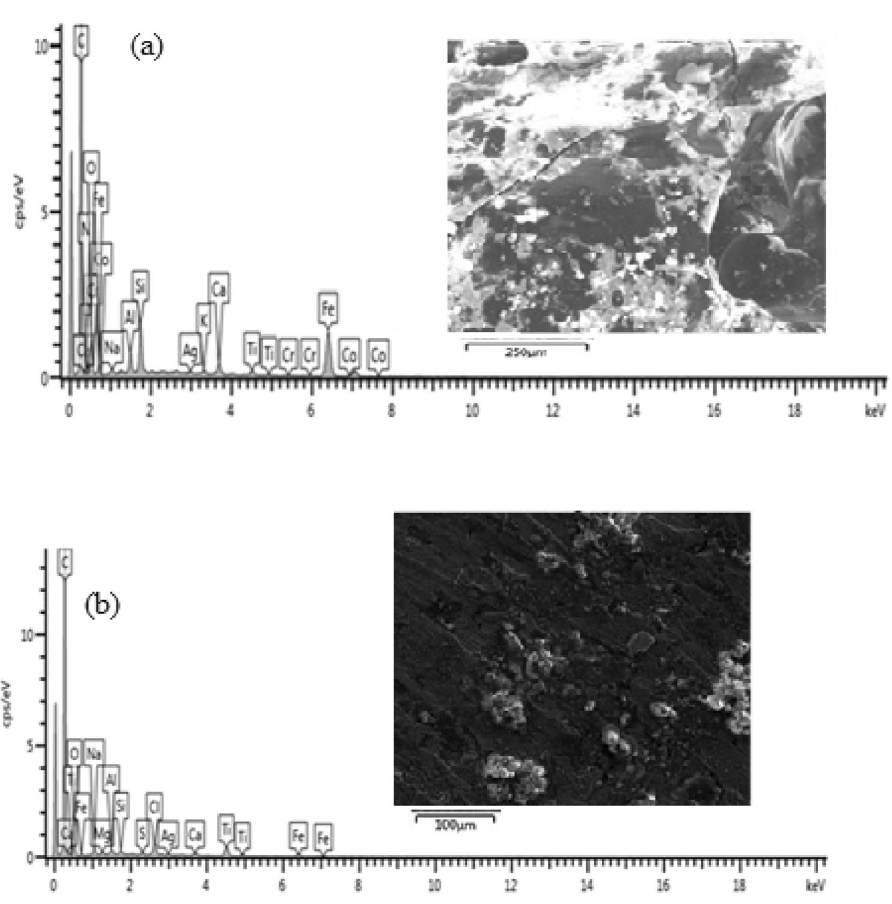
Figure 13. Energy diffraction spectron (EDS) of sample cured at 100 °C: ( a ) before corrosion and ( b ) after corrosion.